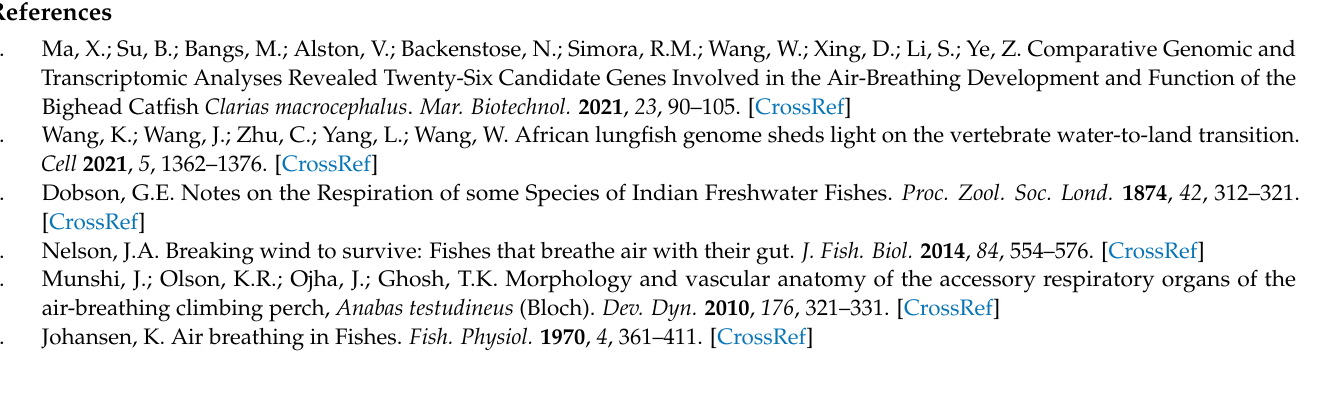
barbels; Figure S2. Functional annotations of DEGs in barbels between T-XU and C-XU groups (T-XU vs. C-XU); Figure S3. Schematic diagram of the conserved domains of the deduced amino-acid sequences of fibronectin 1 gene ( fn1 ) in loach M. anguillicaudatus , compared with three other fish species ( D. rerio , C. argus , and M. albus ); Figure S4. fn1b -depletion loach produced by CRISPR/Cas9 technology; Figure S5. Four treatments used in this study. Table S1. Blood–gas diffusion distances of air-breathing organs in different air-breathing fishes; Table S2. Quality and mapped ratio of clean reads; Table S3. Primers used in this